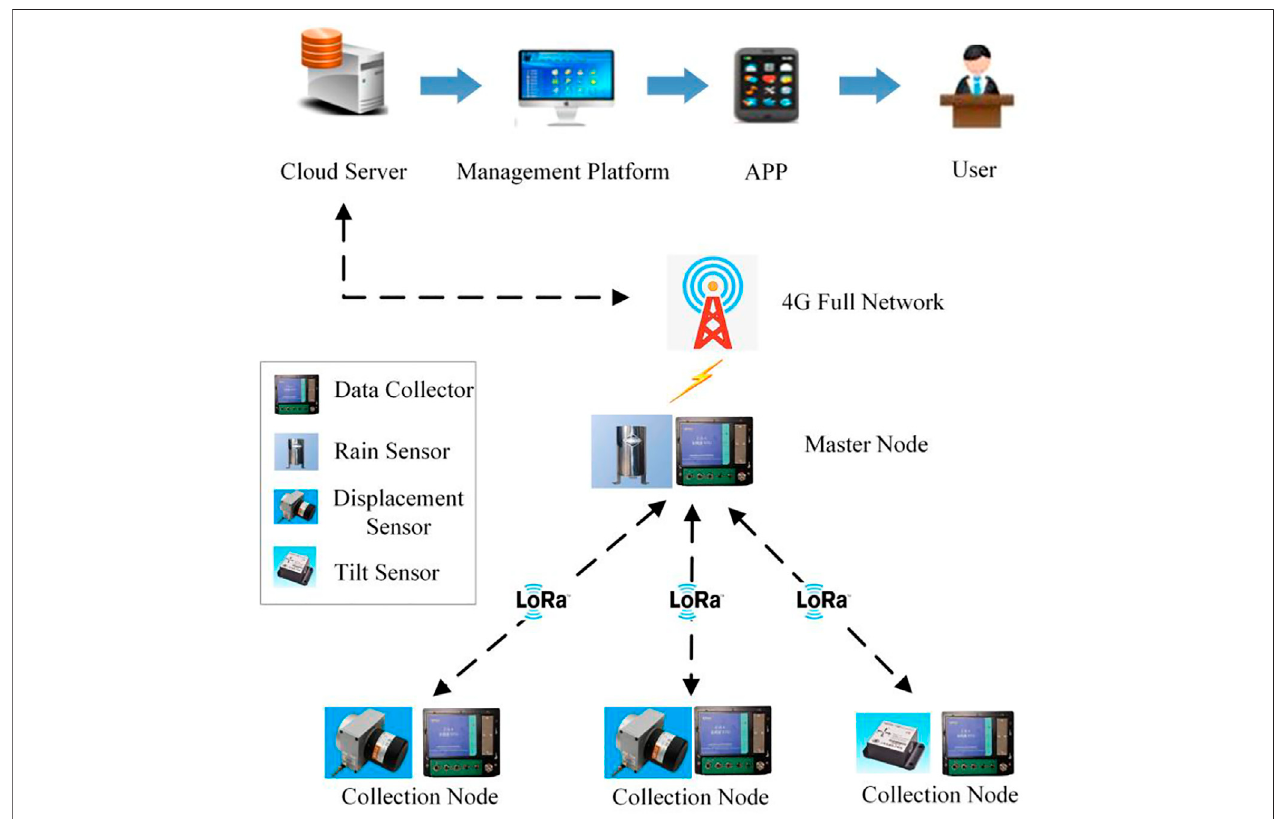
FIGURE 1 | Schematic diagram of the overall design structure of landslide monitoring